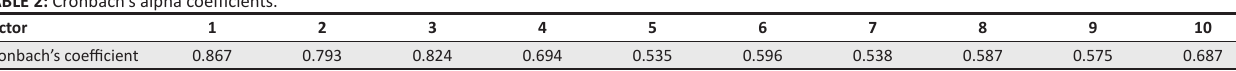
TABLE 2: Cronbach’s alpha